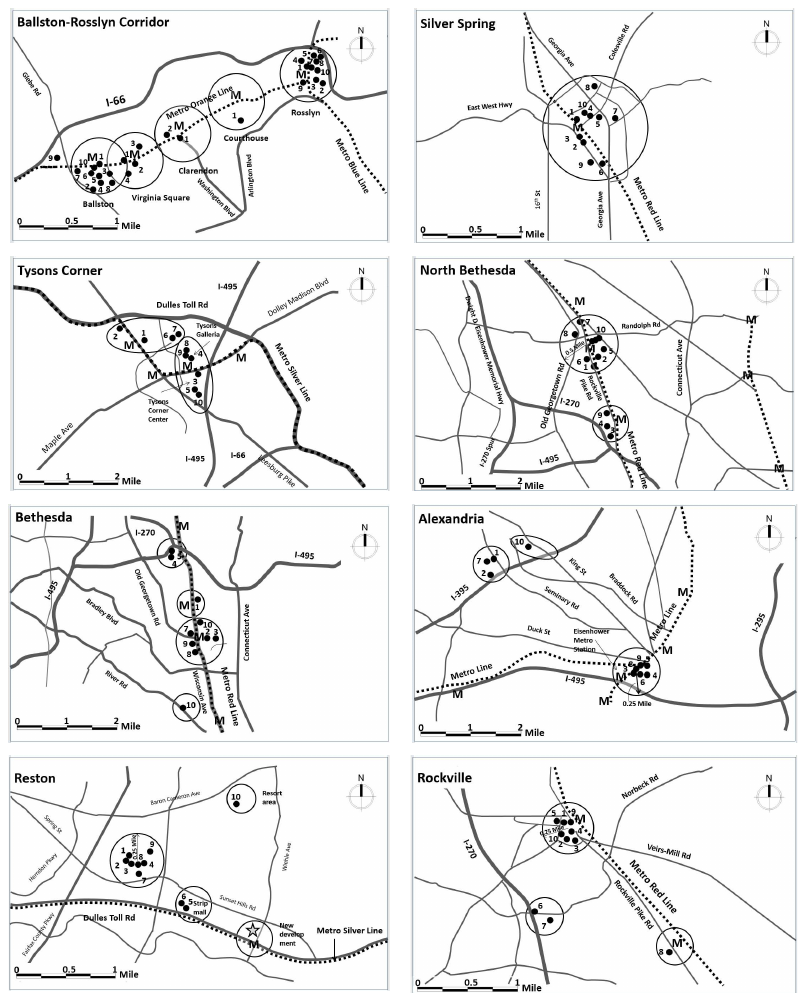
Figure 2. Spatial patterns of tall buildings in suburban communities of Washington, D.C. Metropolitan Area. Each map shows the locations of the ten tallest buildings in its respective suburb.